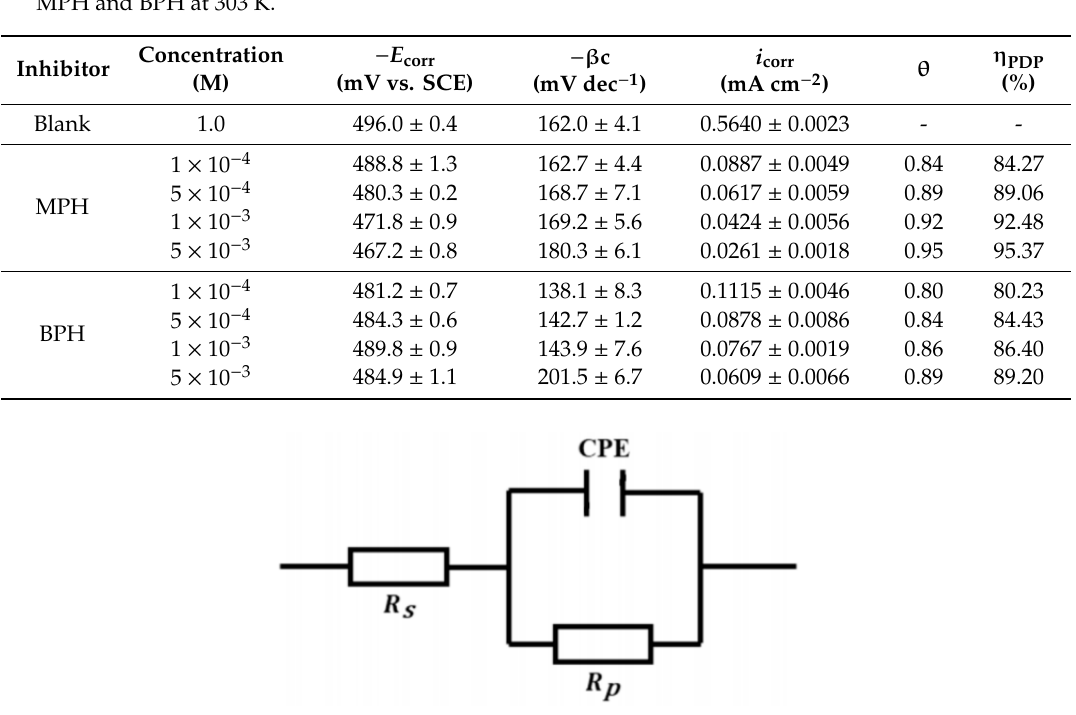
Table 7. Electrochemical parameter values estimated according to electrochemical impedance spectroscopy curves of MS in HCl solution in the presence and absence of several concentrations of MPH and BPH at 303 K.